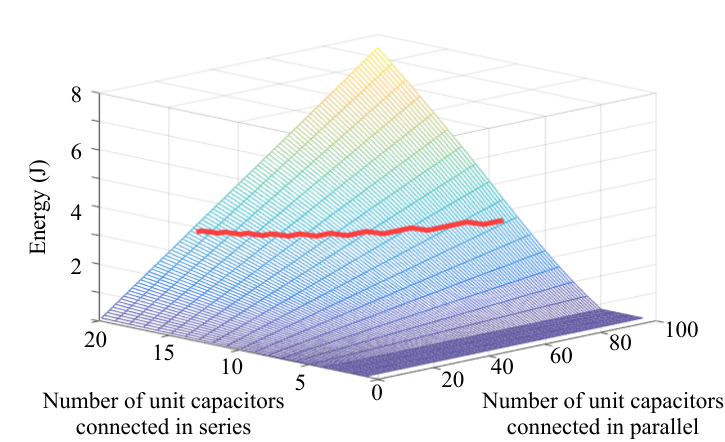
Figure 7. The amount of usable energy from the unit capacitor array. The red line indicates the upper bound of deficient energy to be compensated which is 2.3 J.